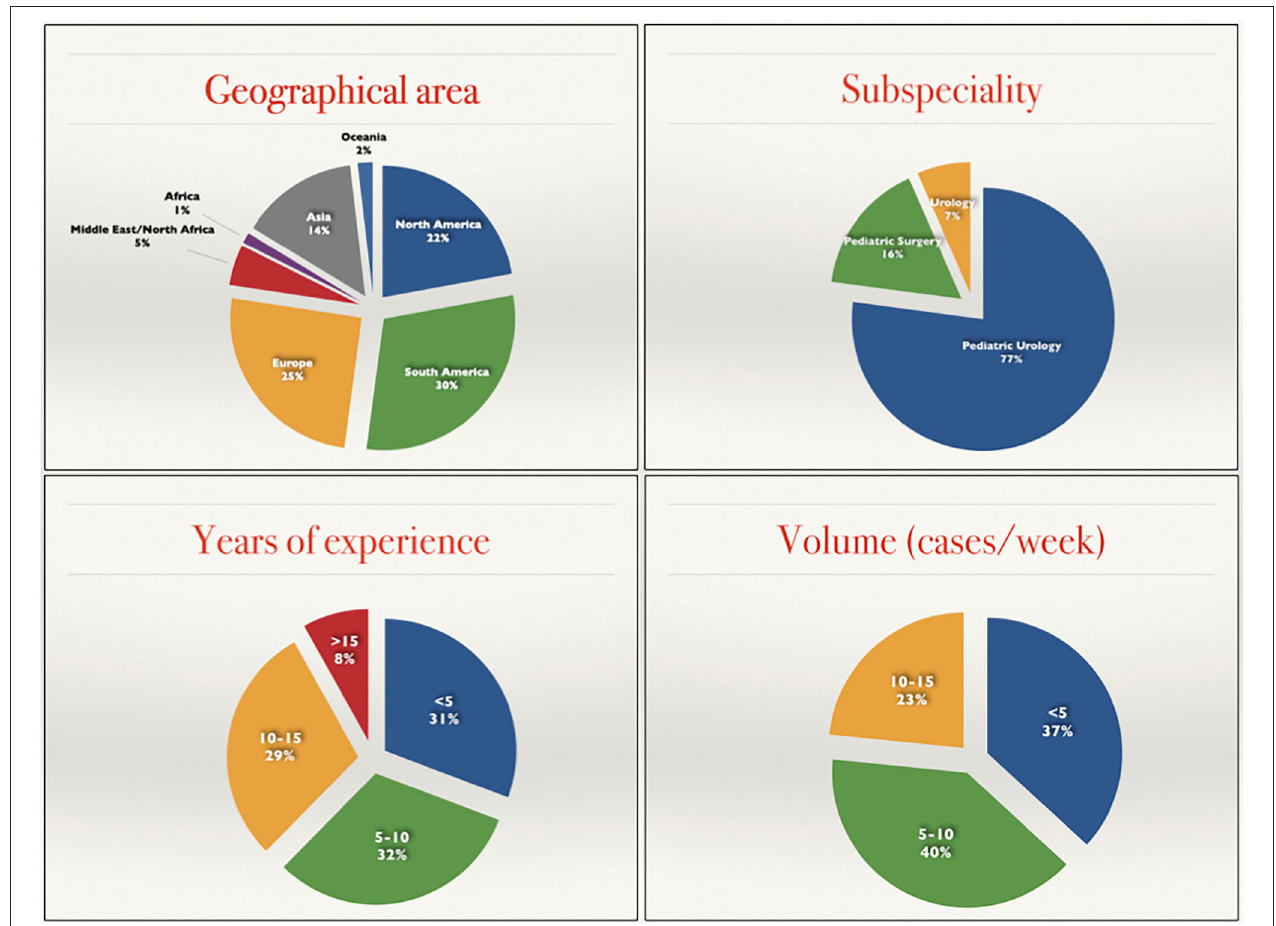
FIGURE 1 | Demographic details of the 380 participants to the study.